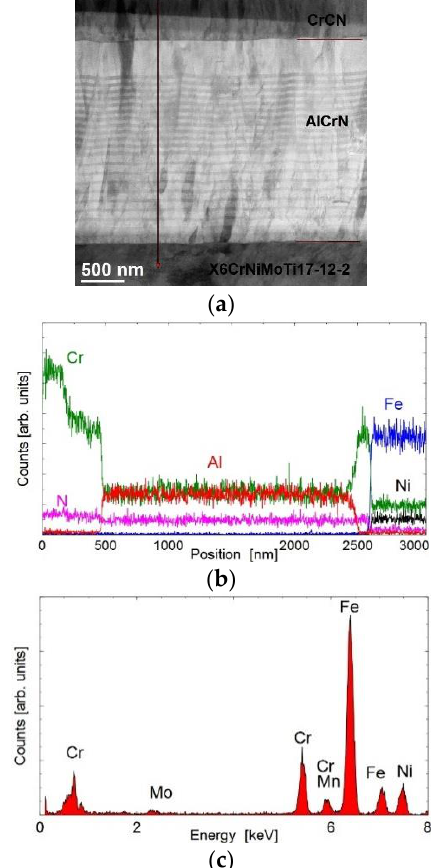
Figure 6. ( a ) STEM-BF image of AlCrN + CrCN coating; ( b ) result of the chemical composition profile analysis; ( c ) result of the chemical composition analysis of the substrate material.